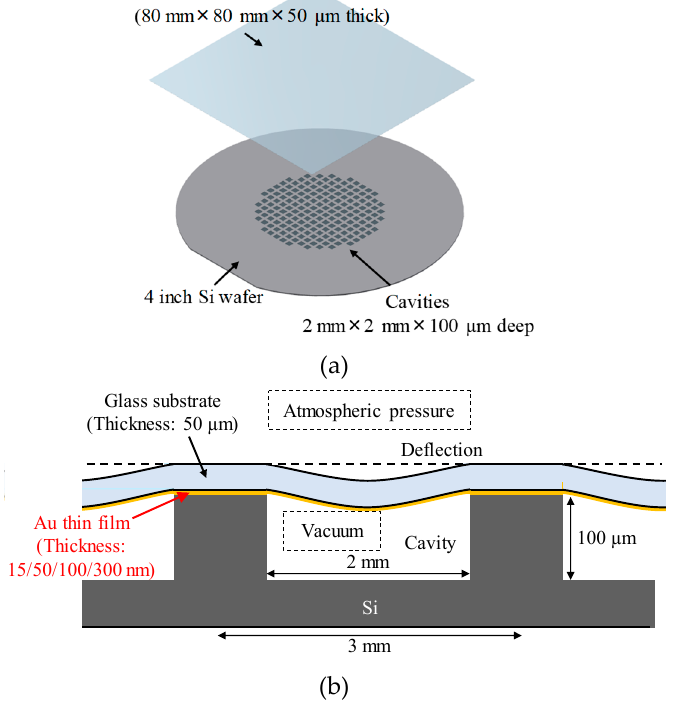
Figure 1. Schematics of bonded wafer pair and bonded structure: ( a ) Wafer pair (thin glass wafer and Si wafer with cavities) deposited with Au thin films ( b ) Cross-sectional schematic of vacuum-sealed sample. Glass substrate exhibited deflection due to pressure difference between sealed vacuum cavity and ambient atmosphere.